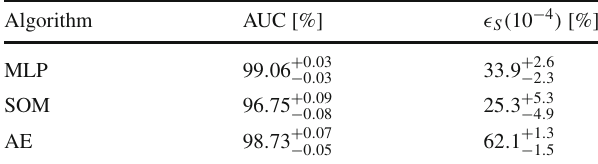
Table 8 Performance metrics of the investigated machine learning techniques for simulated hypothetical dyons